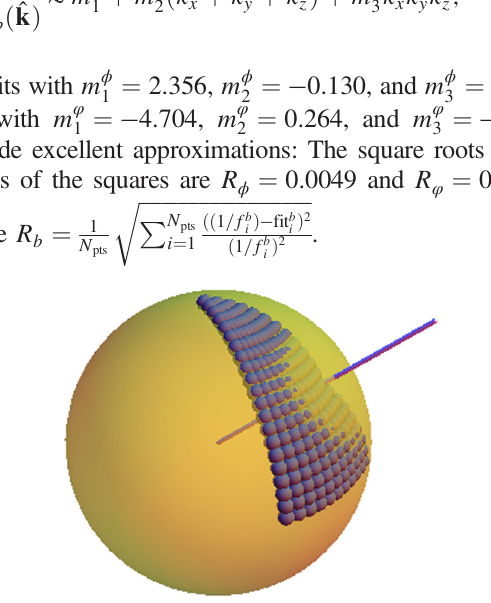
ˆ k FIG. 5. Plot of f ϕ ð Þ =f ϕ ð 001 Þ . The line represents a h 111 i direction. The whole surface can be obtained from the plotted points by applying cubic symmetries (note that the set of plotted points is larger than the minimal set of points). The yellow surface is a sphere of radius f ϕ ð 001 Þ